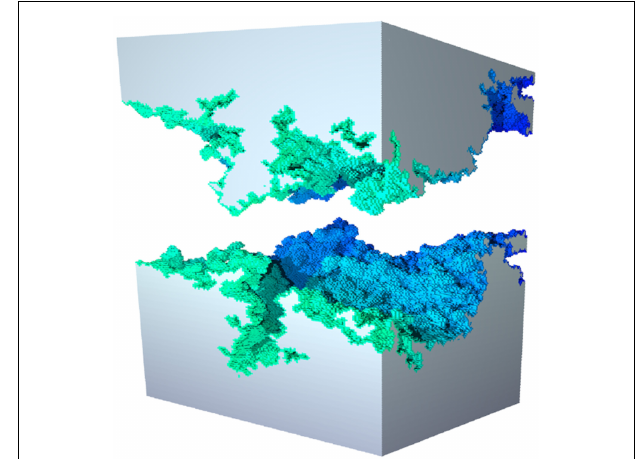
FIGURE 5 | Watershed in three dimensions. Example of a watershed for an uncorrelated three-dimensional space, namely, a simple-cubic lattice of 128 3 sites. To obtain the watershed, sites are sequentially occupied under the constraint that groups of connected sites in contact with the top boundary cannot merge with the ones connected to the bottom boundary. In three dimensions, the fractal dimension is d f = 2 . 487 ± 0 . 003